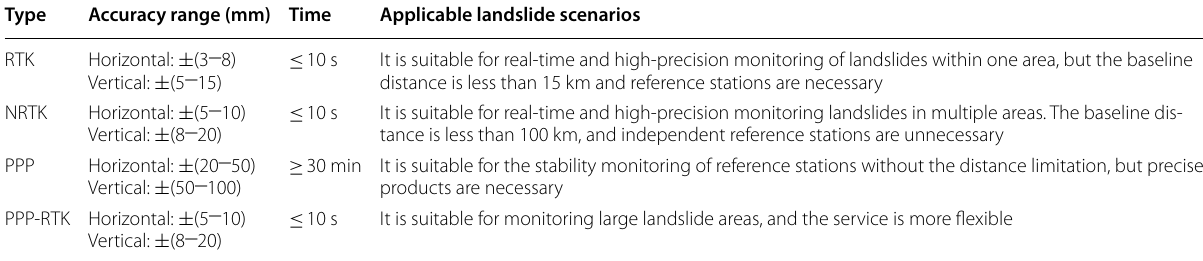
Table 1 Advantages and disadvantages of several high-precision GNSS monitoring technologies Type Accuracy range (mm) Time Applicable landslide